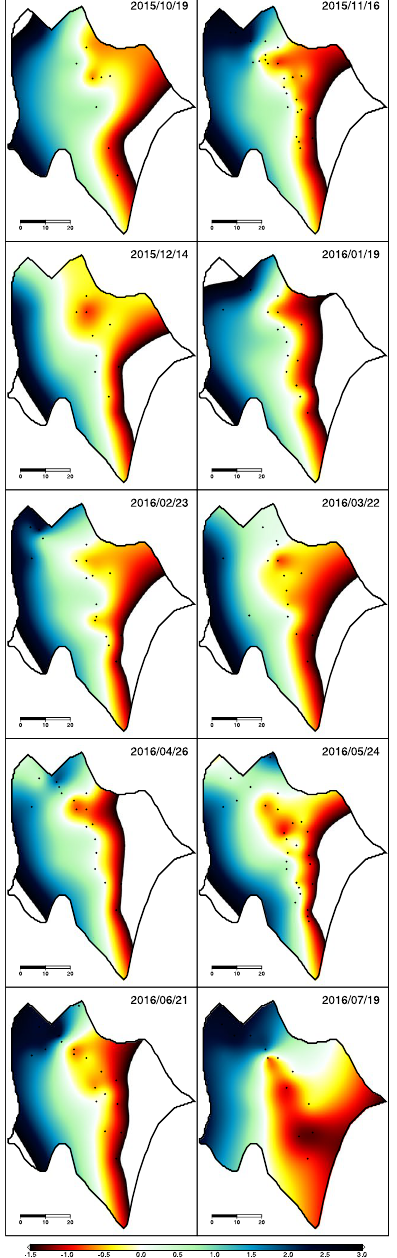
Fig. 6 The colored contour plot of F1 scores on 10 investigations. Black dots denote sampled mud pools. The unit of scale the bar is meter. Low score mud pools (red) dominate eastern and southeastern sides of the field, representing high contribution of igneous signals. High score mud pools (dark blue) dominate western and northwestern sides, representing contribution from sedimentary rocks. The southeastern side shows consistent condition during the sampling period while the northwestern side and the central part display variations. The end member sites are used as constrain points (i.e. D4, E1, F1, and F2)